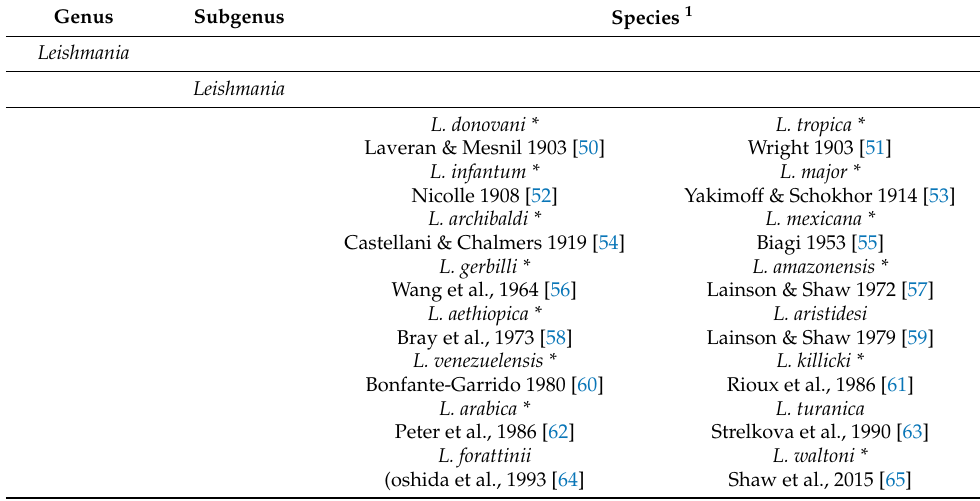
Table 2. Classification of Leishmania species (Class Kinetoplastea; Order Trypanosomatida; Family Trypanosomatidae; Subfamily Leishmaniinae), excluding synonyms, nomen nudum and those not completely